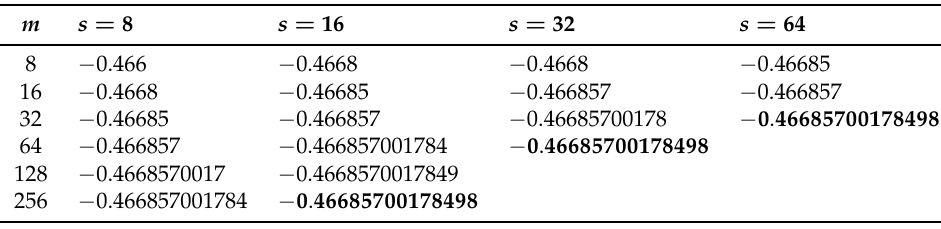
(cid:82) = 1 sin x dx − 1 ( x − 0.1 ) 2